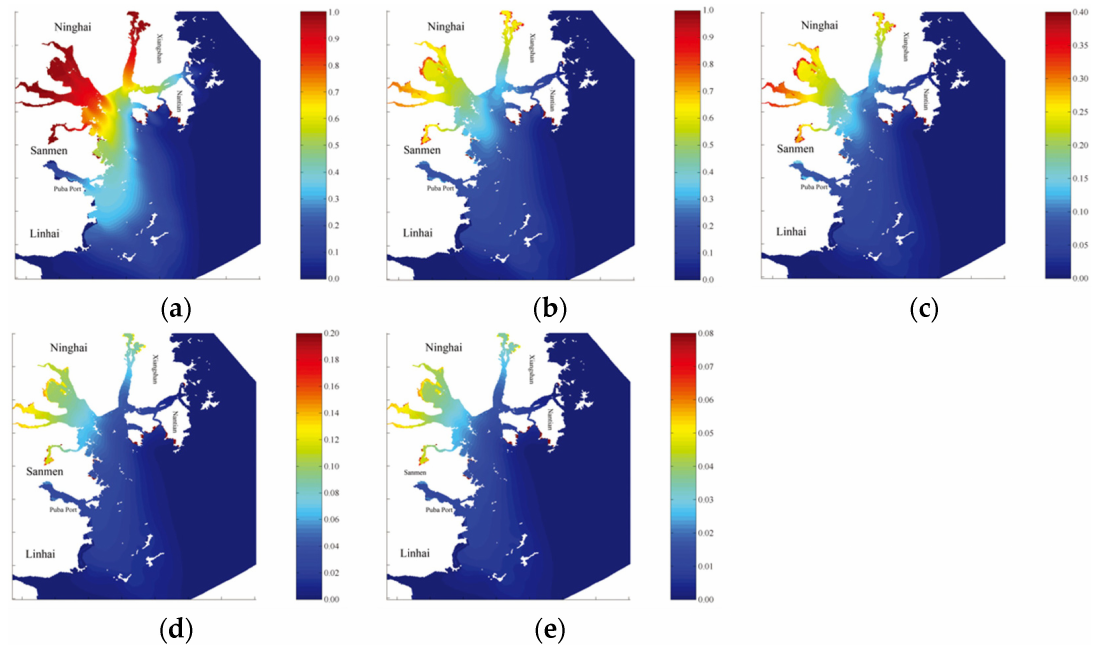
Figure 7. Conserved matter distribution after 5 days ( a ), 15 days ( b ), 30 days ( c ), 45 days ( d ) and 60 days ( e